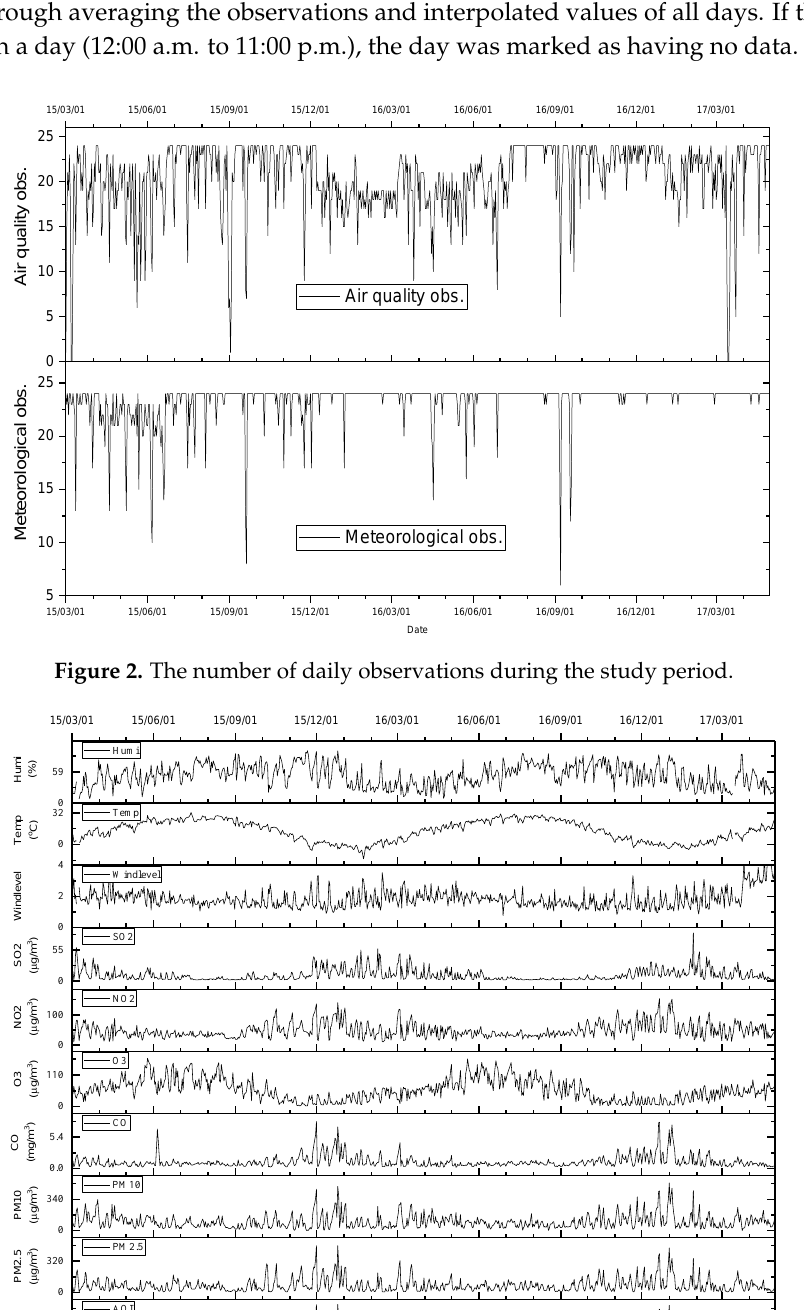
Figure 3. The time series of daily meteorological factors (mean temperature, mean relative humidity, and mean wind level), pollutant concentrations, and the Ministry of Environmental Protection (MEP) air quality index (AQI).